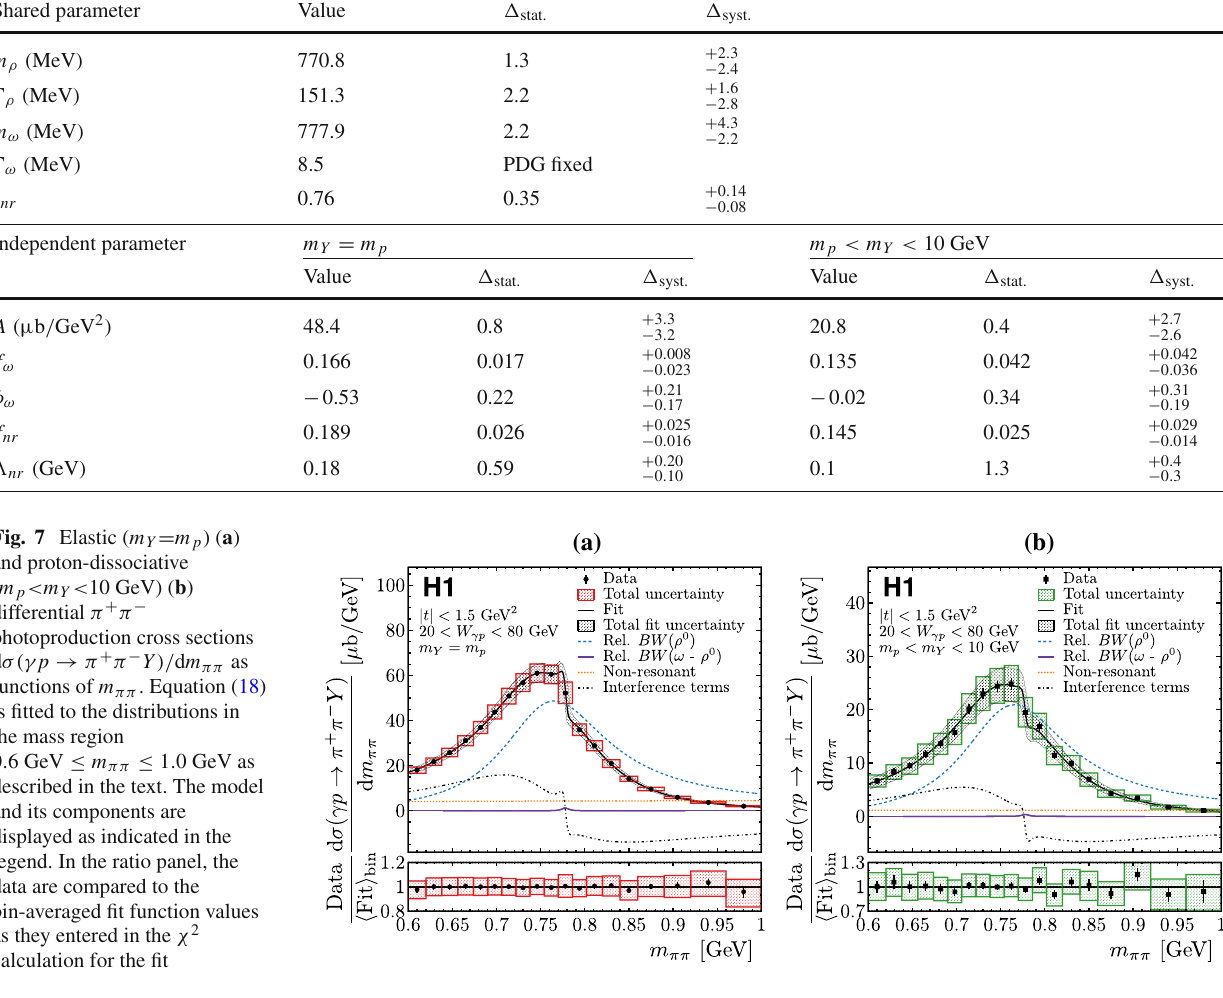
uncertainties are given. A full uncertainty breakdown and statistical correlations are provided [77]. The corresponding fit is shown in Fig. 7